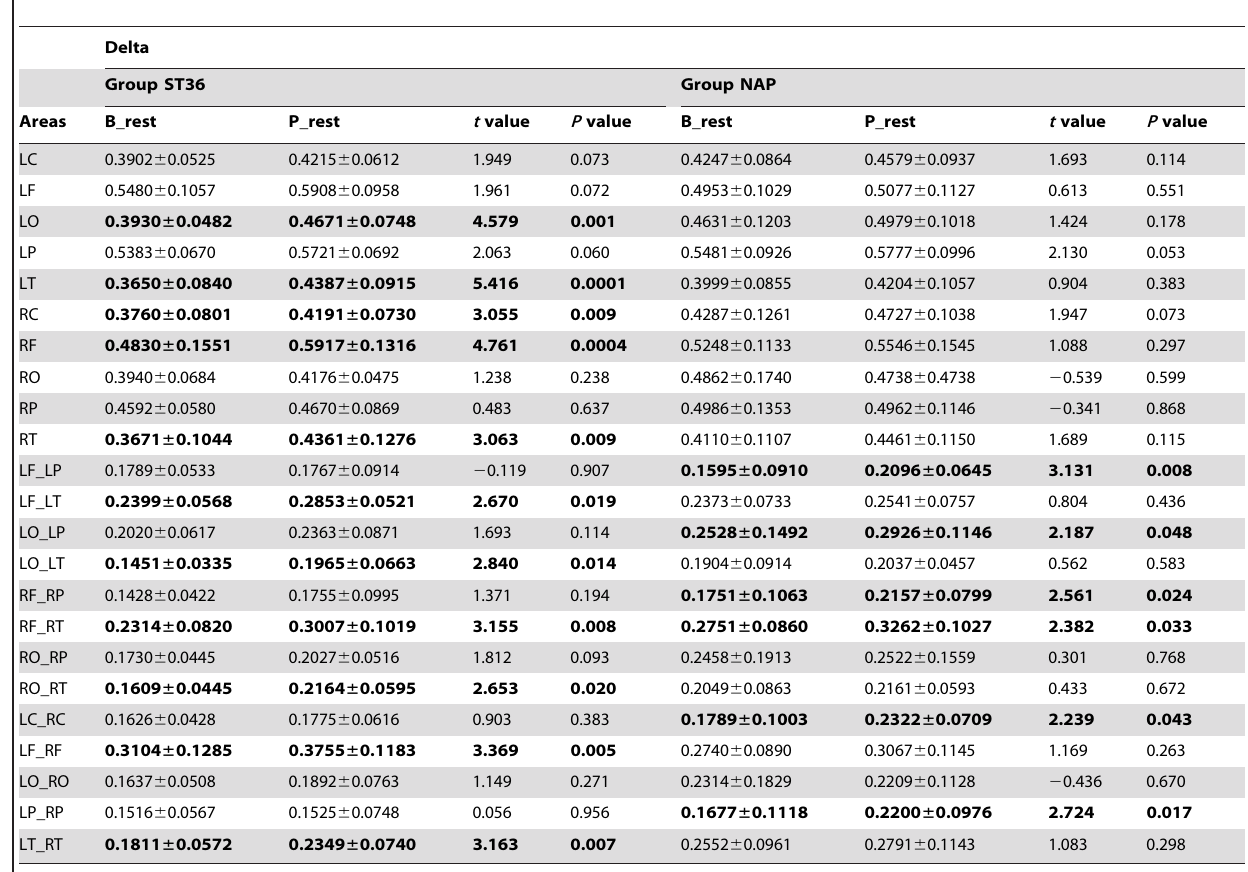
Table 1. Functional connectivity within and between main regions and statistical results in the delta bands for the ST36 and NAP groups.